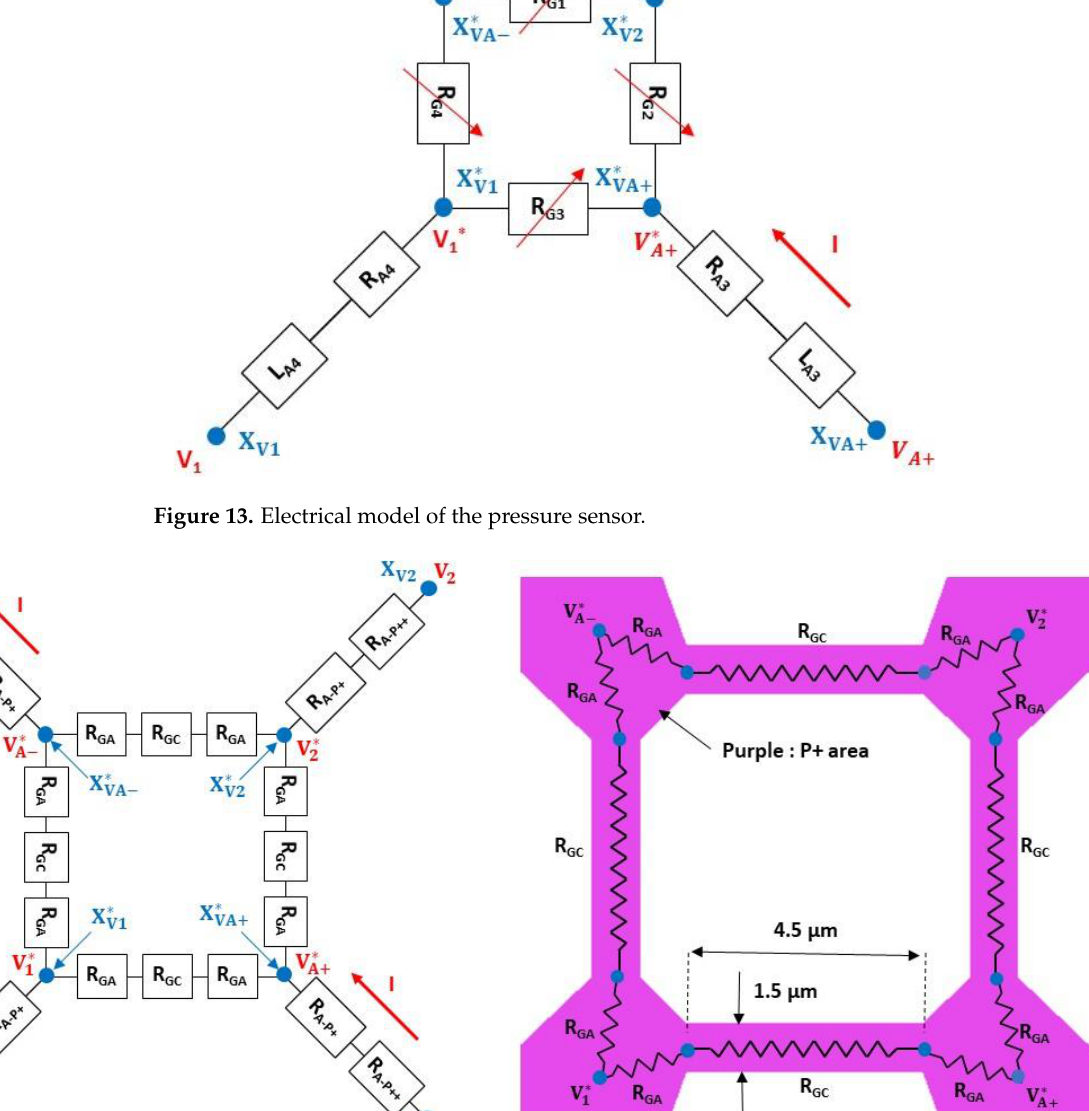
Figure 14. Electrical model for constitutive resistor without differential pressure applied on the membrane.